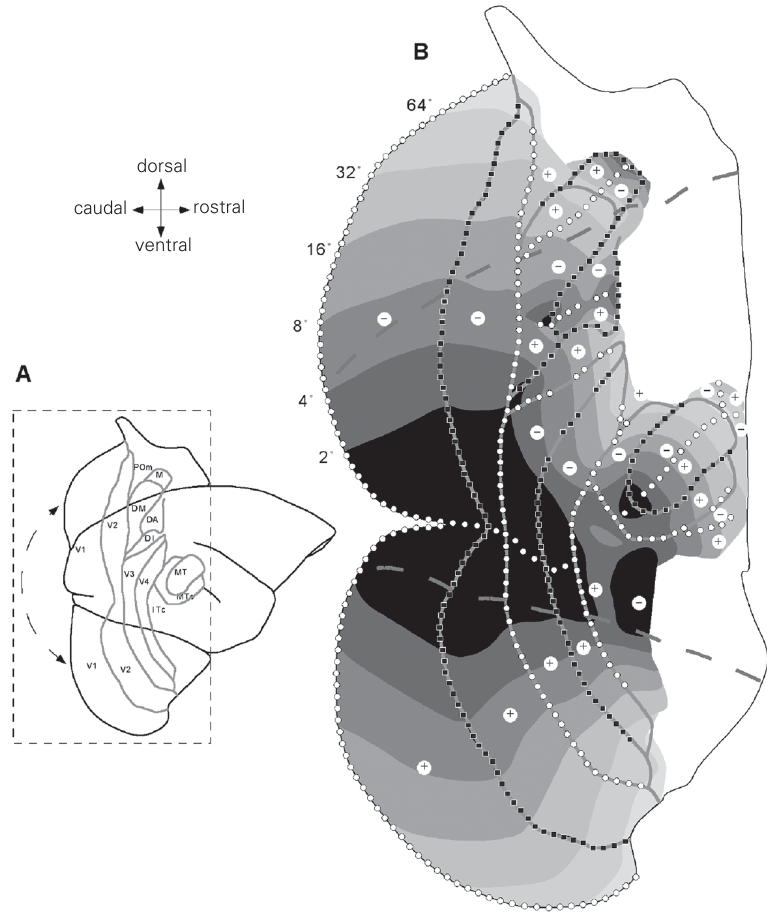
Figure 3. Supra-areal visuotopic organisation of primate visual cortex. A , Lateral view of the right hemisphere of a marmoset monkey, illustrating the anatomical relationships within the cortical region shown in part B. In generating this figure parts of the cerebral cortex normally hidden from view (those located along the dorsal midline and ventral surface) have been graphically “unfolded”; moreover, an artificial discontinuity has been introduced along the horizontal meridian representation in V1 (arrows). The grey lines indicate the boundaries of cortical areas, according to a scheme of subdivision based on physiological mapping and architecture (6,10,29). B , Magnified view of the same map, with the visual topography indicated. The thick dashed lines indicate the dorsal and ventral limits of the cortex that is normally exposed on the dorsal and lateral surfaces of the brain. The numbers to the left of V1 indicate the range of receptive field centre eccentricities observed within the regions coded by the different tones of grey (0-2 (cid:1) , 2-4 (cid:1) , 4-8 (cid:1) , etc.). Representations of the horizontal meridian are indicated by white circles, representations of the vertical meridian by black squares, representations of the upper quadrant by the “+” signs, and those of the lower quadrant by the “-” signs. Although it is likely that visuotopy extends beyond the areas shown in this figure, the detailed organisation of these maps has not yet been established in the marmoset. POm, parietooccipital medial area; M, medial visual area; DM, dorsomedial area; DA, dorsoanterior visual area; DI, dorsointermediate visual area; MT, middle temporal visual area; MTc, middle temporal crescent; ITc, caudal subdivision of the inferior temporal visual